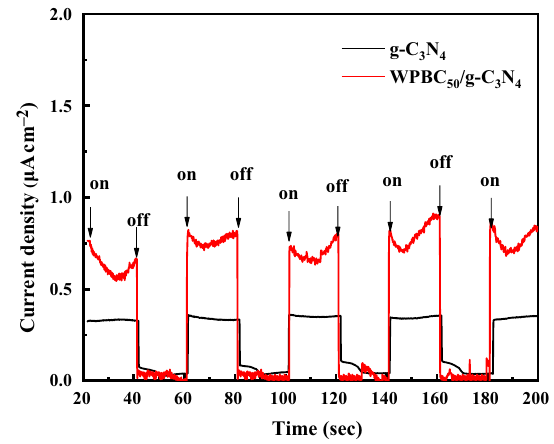
Fig. 8 Photocurrent responses of g-C